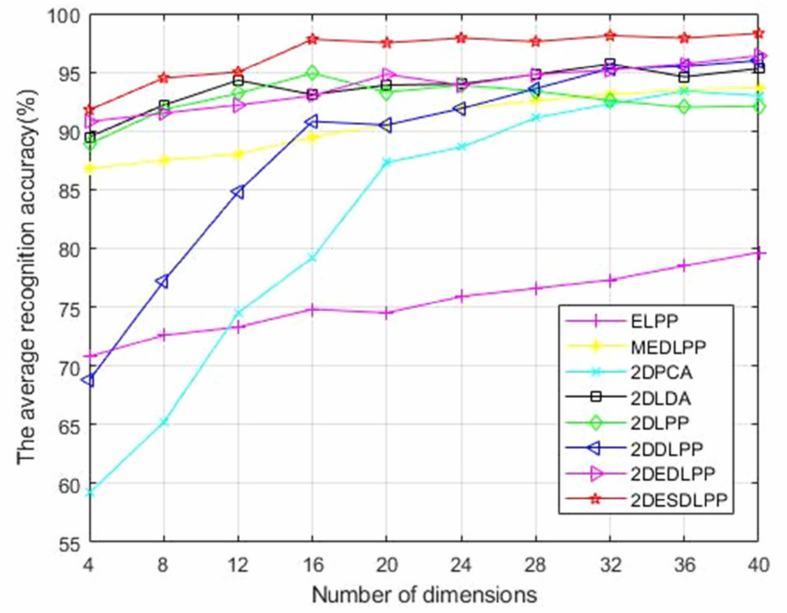
Figure 8. Average recognition rate (%) with feature dimension for different algorithms when the number of training samples in the Yale face database is 6. Table 4. Maximum average recognition rate (%) of 2DESDLPP and other seven comparison algorithms and the corresponding number of dimensions in the Yale database.